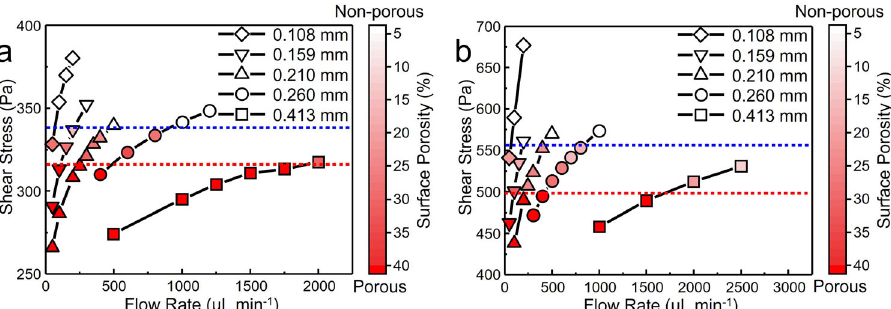
Fig. 2 The relationship between shear stress and surface porosity. Surface shear stress and surface porosity of aerogels with ( a ) 40 mM AA and with ( b ) 6 mM Ca 2 + printed at different fl ow rates and by nozzles with different diameters. The red and the blue lines mark the shear stress threshold of porous surface and non-porous surface, respectively. Surface shear stress is obtained by CFD simulation (see